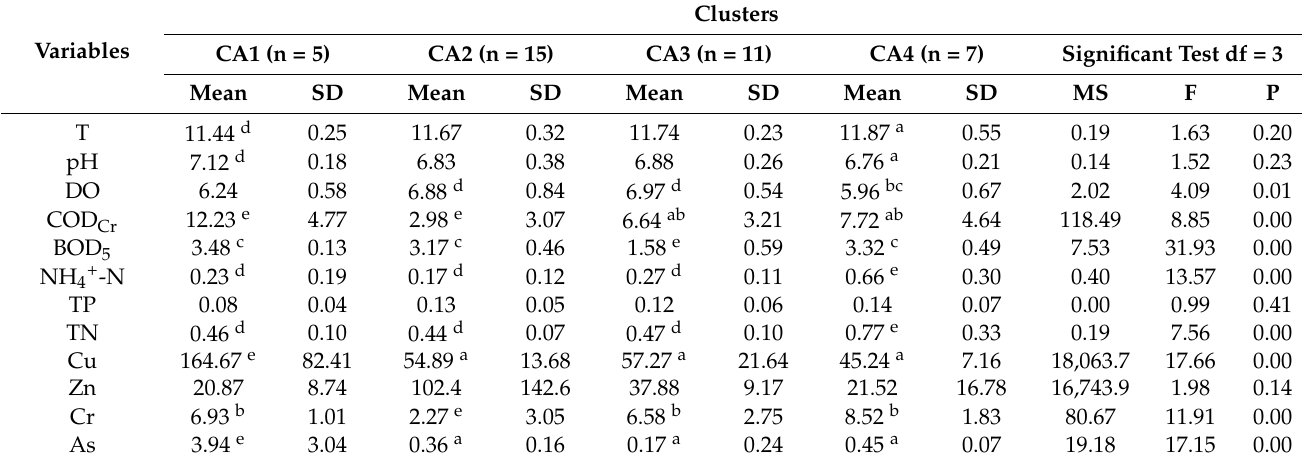
Table 3. Concentrations, ANOVA and significant test of the four clusters by cluster analysis in the Xiujiang River, China.